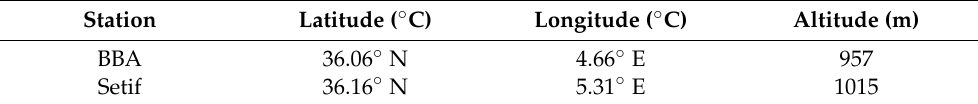
Table 1. Geographical coordinates and altitudes of the of the Setif and BBA meteorological stations. Station Latitude ( ◦ C) Longitude ( ◦ C) Altitude (m) BBA 36.06 ◦ N 4.66 ◦ E 957 Setif 36.16 ◦ N 5.31 ◦ E